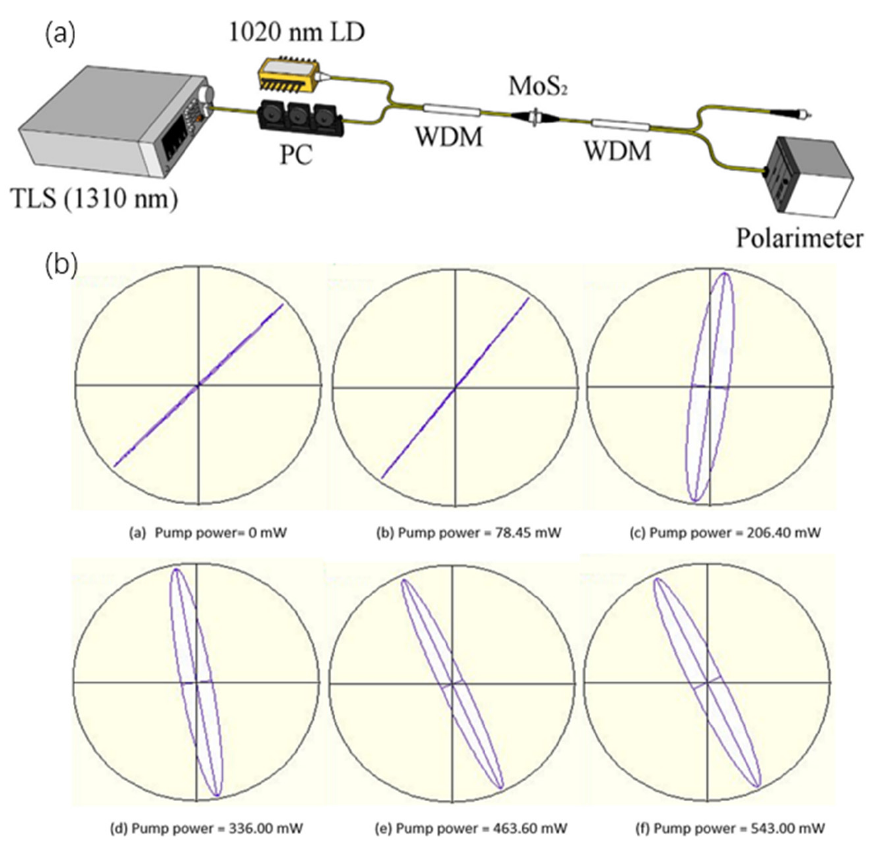
Figure 15. All-optical polarization modulation based on MoS 2 /PVA thin film. ( a ) Schematic of the experimental setup of amplitude modulator based on MoS 2 PVA thin film, ( b ) Change of light polar- ization with the increment of pump power. Reprinted with permission from Ref. [142]. Copyright 2019, Elsevier.